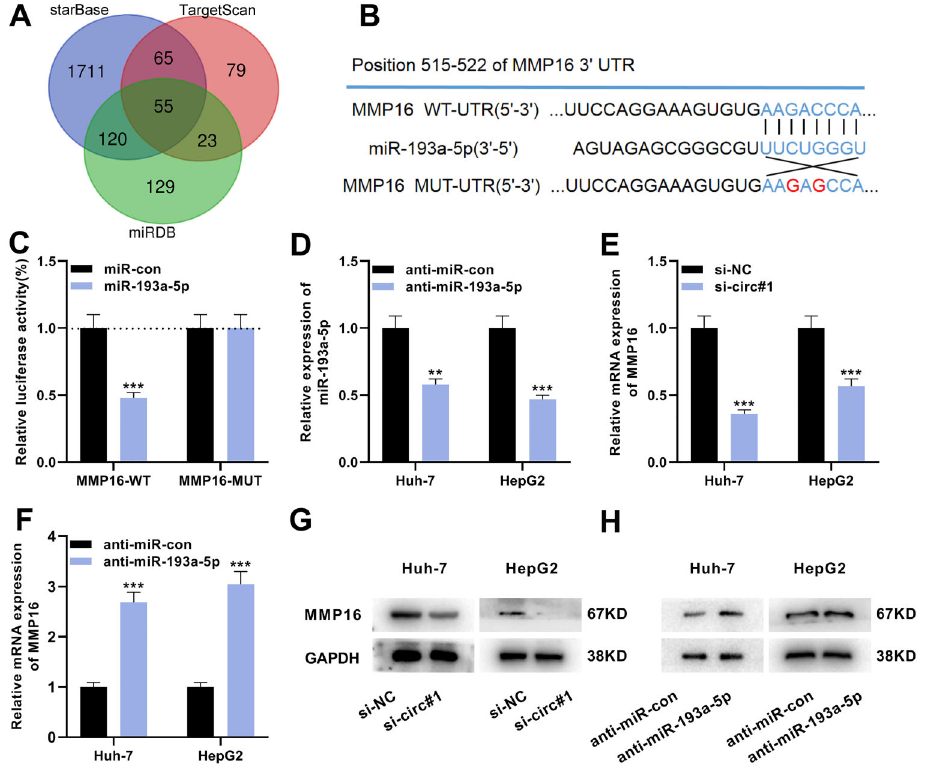
Figure 4. MMP16 is the direct target of miR-193a-5p. A , Bioinformatics analysis was performed with starBase, TargetScan, and miRDB to predict the candidate mRNAs, which could be targeted by miR-193a-5p. B , Bioinformatics analysis predicted that the sequence of MMP16 3UTR matched the sequences of miR-193a-5p, and MMP16-WT (wild-type) and MMP16-MUT (mutant) luciferase reporter gene vectors were constructed. C , The miR-193a-5p mimics (or miR control) were co-transfected with MMP16-WT (or MMP16-MUT) into HEK293T cells, and the luciferase activity of the cells in each group was measured. D , Huh-7 and HepG2 cells were transfected with anti-miR-193a-5p and negative control (NC), and the expression level of miR-193a-5p was detected by qRT-PCR. E , qRT-PCR was used to detect the expression of MMP16 mRNA in Huh-7 and HepG2 cells after circ_0001806 knockdown. F , qRT-PCR was used to detect the expression of MMP16 mRNA in Huh-7 and HepG2 cells transfected with anti-miR-193a-5p. G , Western blot was used to detect the expression of MMP16 protein in Huh-7 and HepG2 cells after circ_0001806 knockdown ( G ) and in Huh-7 and HepG2 cells transfected with anti-miR-193a-5p ( H ). Data are reported as means ± SD. **P o 0.01, ***P o 0.001 ( t